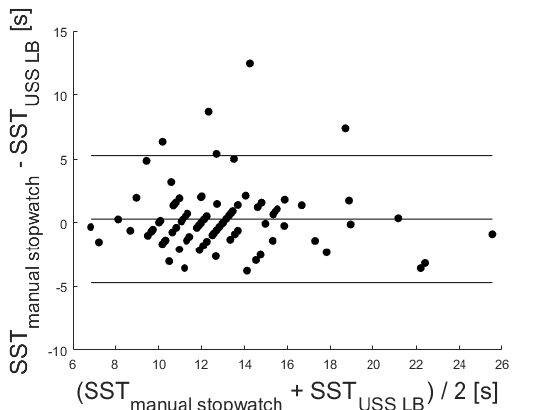
Figure 9. Linear regression among manual stopwatch measurements and the USS LB measurements for the SST.